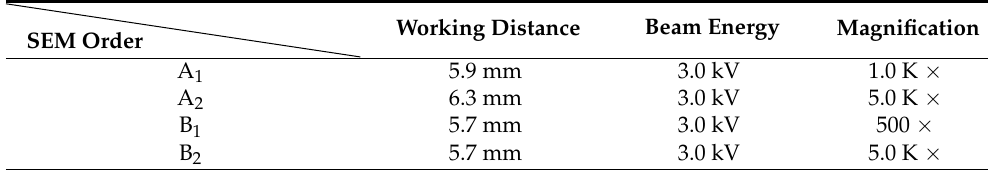
Table 2. SEM specific